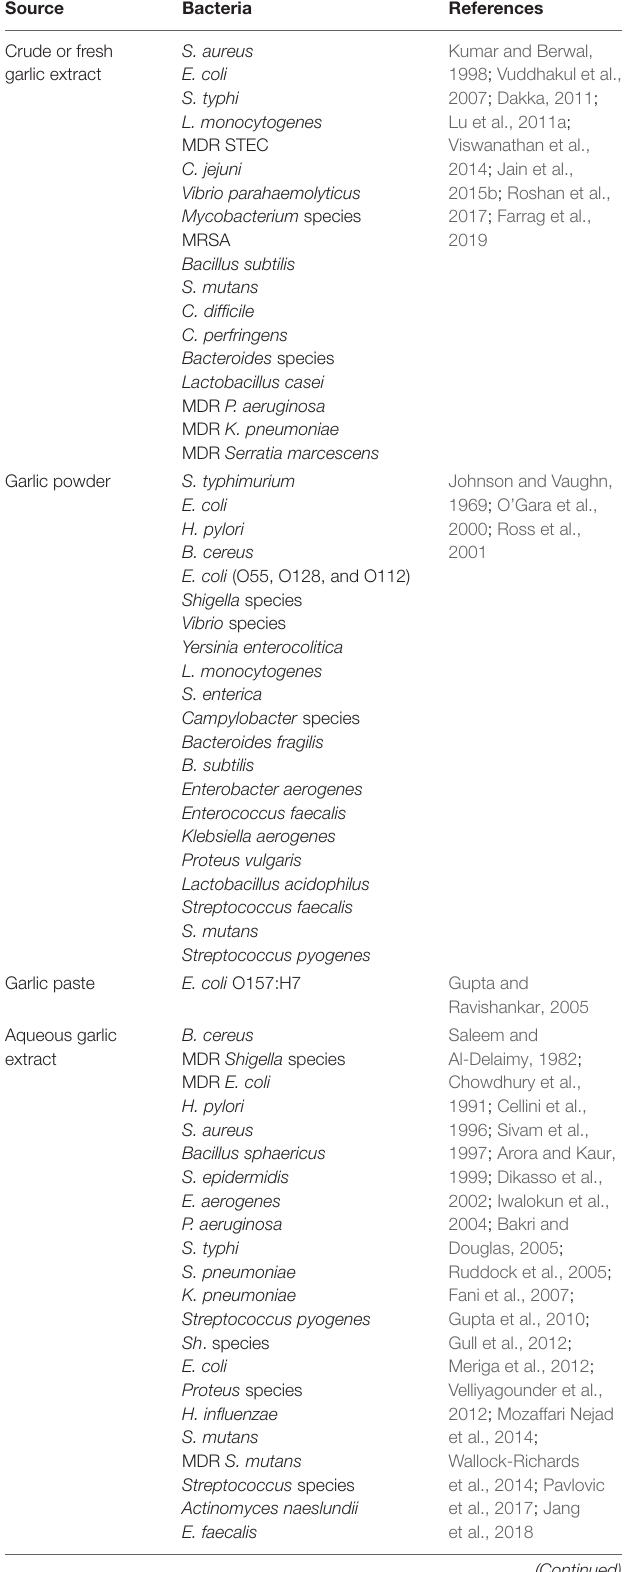
TABLE 1 | In vitro antibacterial activity of various garlic products and